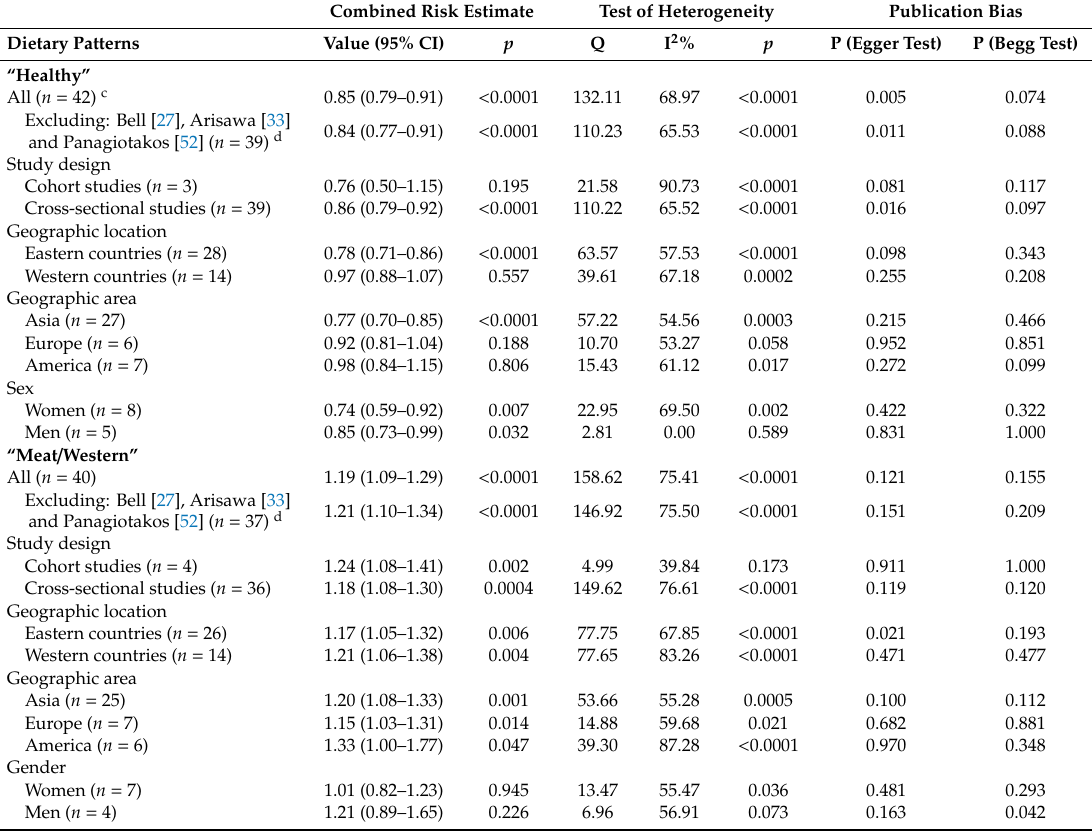
Table 2. Results of stratified analysis of the Metabolic Syndrome risk estimates for the highest compared with the lowest intake categories of “Healthy” and “Meat / Western” dietary patterns a,b